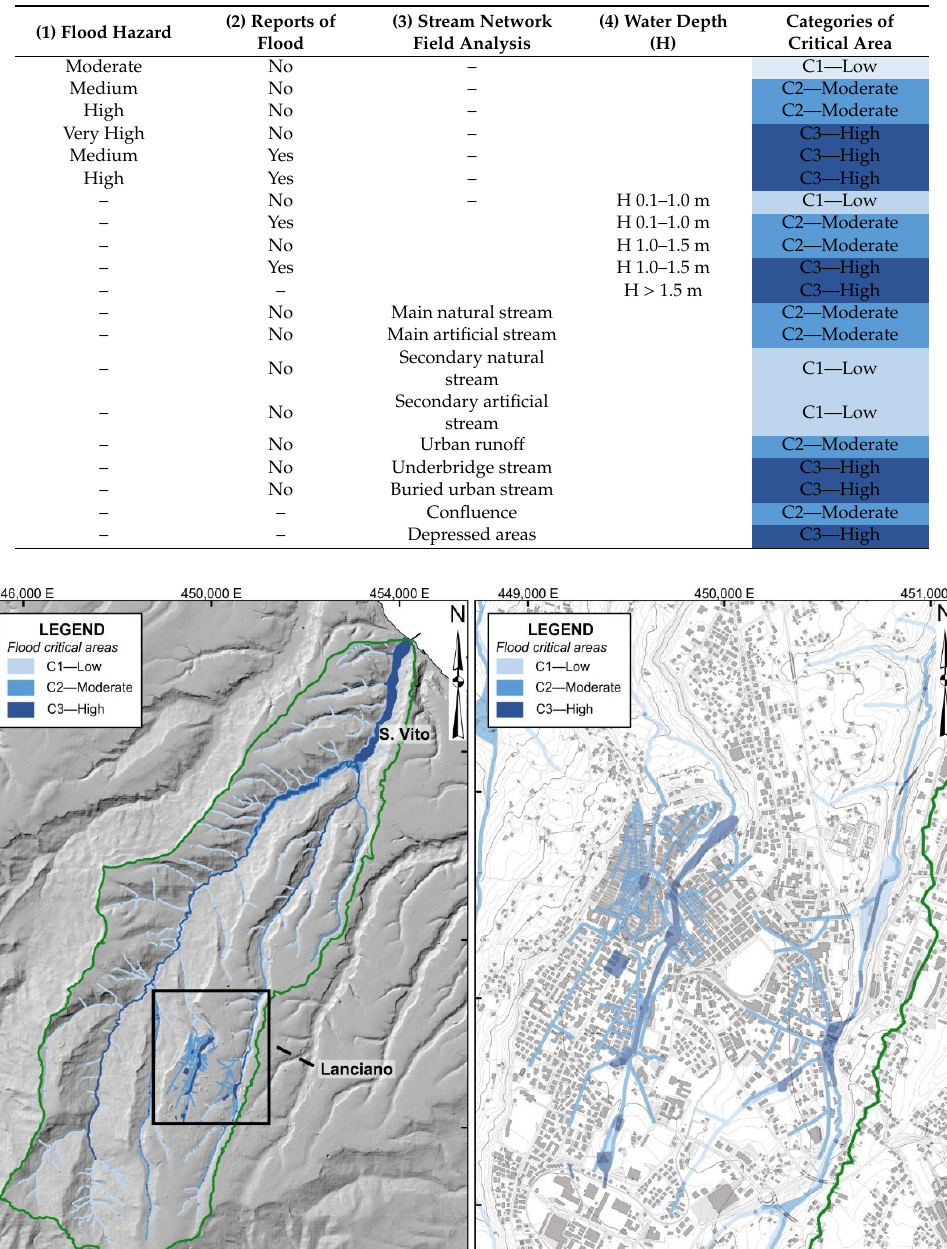
Table 6. Geomorphology-based matrix for flood critical areas. The expert-based analysis and overlay of the data in the first columns, allow the definition of the categories of critical areas (i.e., if one of the conditions or combinations of columns 1, 2, 3, 4 occur, then the category of a critical area in the corresponding row is defined).